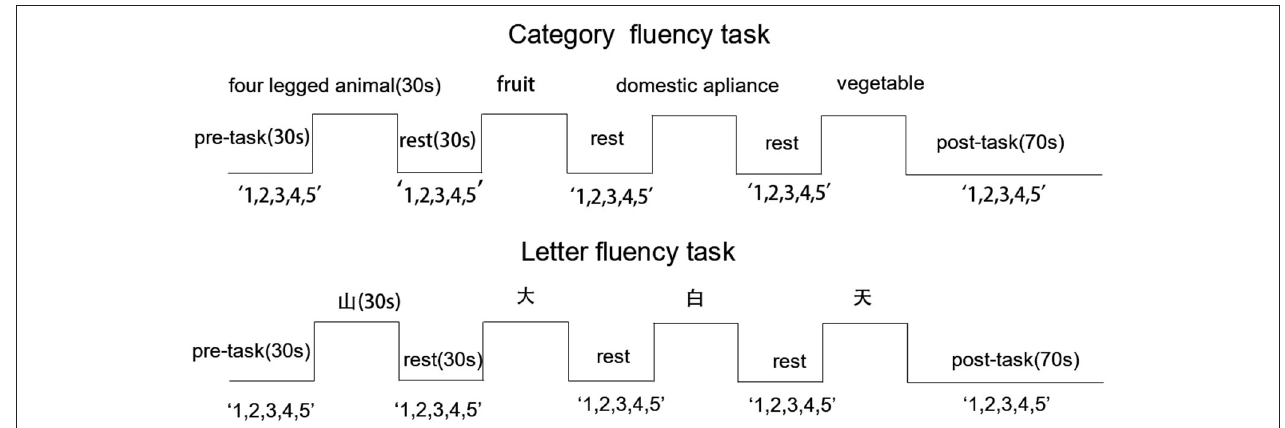
FIGURE 1 | Activation task design. Cues are presented along the top and “1,2,3,4,5” indicates that participants were requested to count from 1 to 5 repeatedly during pre-task, inter-trial, and post-task periods. Excepted for the 70-s post-task period, all other periods were 30s.